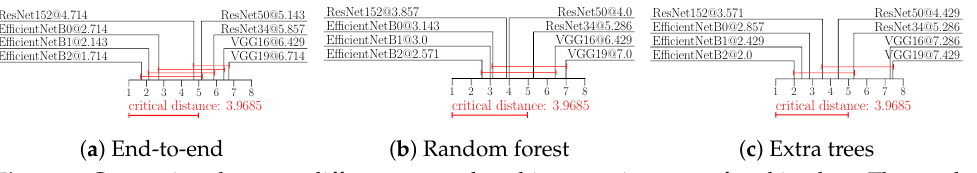
Figure 7. Comparison between different network architectures in terms of ranking loss. The results are presented in the form of average rank diagrams at 0.05 significance level for ( a ) End-to-end learning, ( b ) Random forests and ( c ) Extra trees. The best ranking methods are at the left-most side of the diagram. The difference in performance among the methods connected with a red line is not statistically